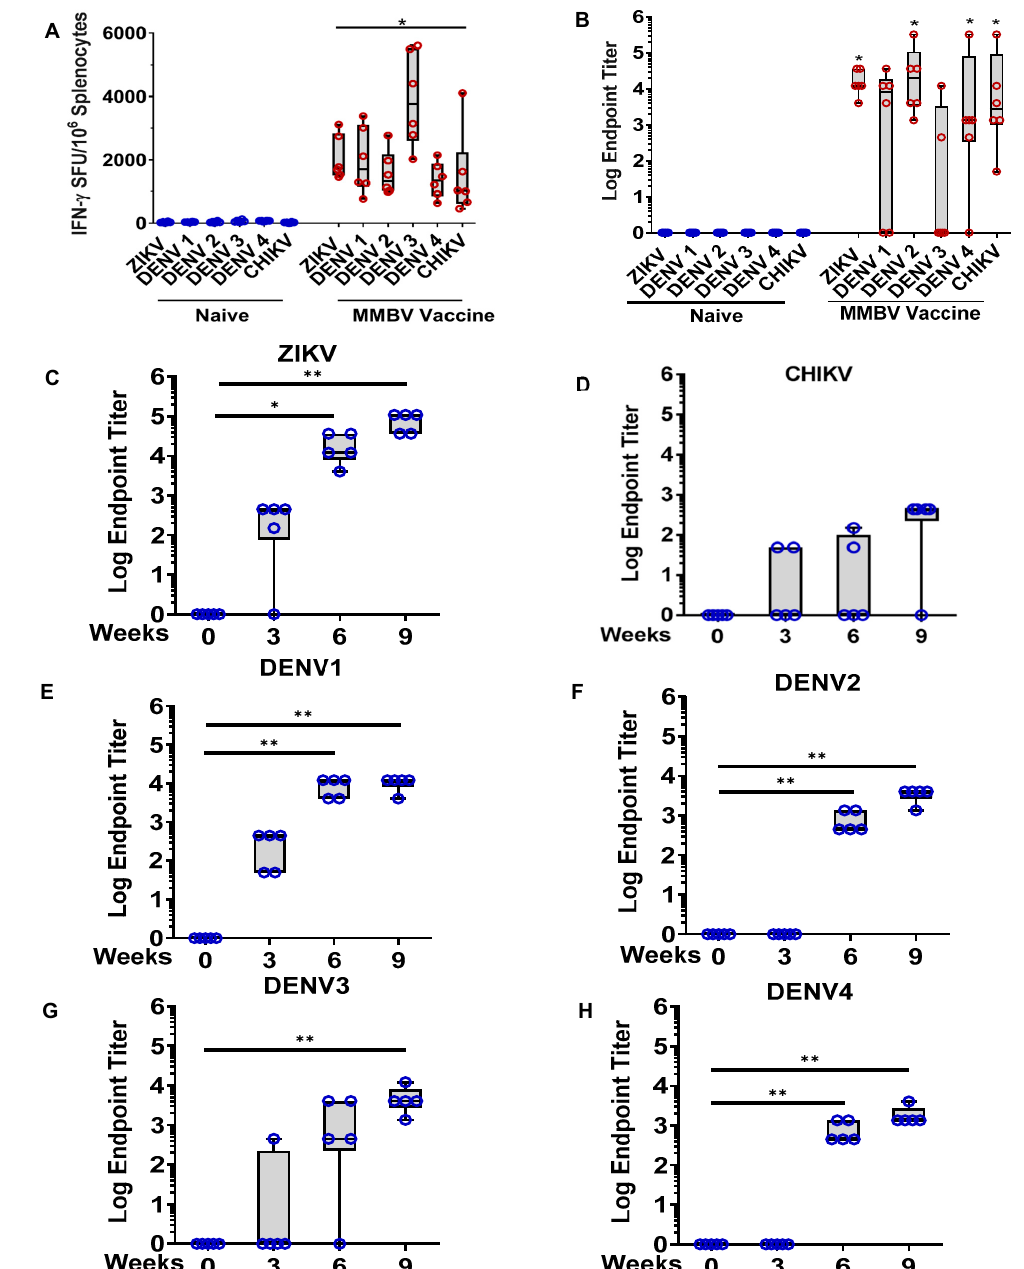
Figure 3. MMBV DNA vaccine induces cellular and humoral immune responses in mice and guinea pigs. ( A , B ) C57BL/6 mice ( n = 6/group) were untreated (naïve) or immunized with MMBV DNA vaccine as a cocktail of pZIKV, pDENV1–4, and pCHIKV plasmids delivered by IM-EP on days 0, 14, and 28 and assessed for cellular ( A ) and humoral ( B ) immune responses two weeks post final immunization. ( A ) Isolated splenocytes were stimulated with the indicated viral envelope peptide pools and antigen-specific T cells detected by IFN γ ELISpot assay. Data represents SFUs per million splenocytes for individual mice. ( B ) IgG antibodies in serially diluted sera samples were measured by binding ELISA against the indicated viral envelope proteins. Data represents binding IgG EPTs for individual mice. Asterisks indicate a significant difference in IFN γ SFUs or IgG EPTs compared to naïve mice as described in the methods. ( C–H ) Hartley guinea pigs ( n = 5) were immunized with MMBV DNA vaccine as a cocktail of pZIKV, pDENV1-4, and pCHIKV plasmids delivered by ID-EP on days 0, 21 and 42. Serum IgG antibody endpoint titers (EPTs) for individual guinea pigs were measured at the indicated timepoints by binding ELISA against ZIKV ( C ), CHIKV ( D ), DENV1 ( E ), DENV2 ( F ), DENV3 ( G ), and DENV4 ( H ) envelope proteins. Data represents binding IgG EPTs of individual guinea pigs. Asterisks indicate significant difference in IgG EPTs compared to Week 0 as described in the